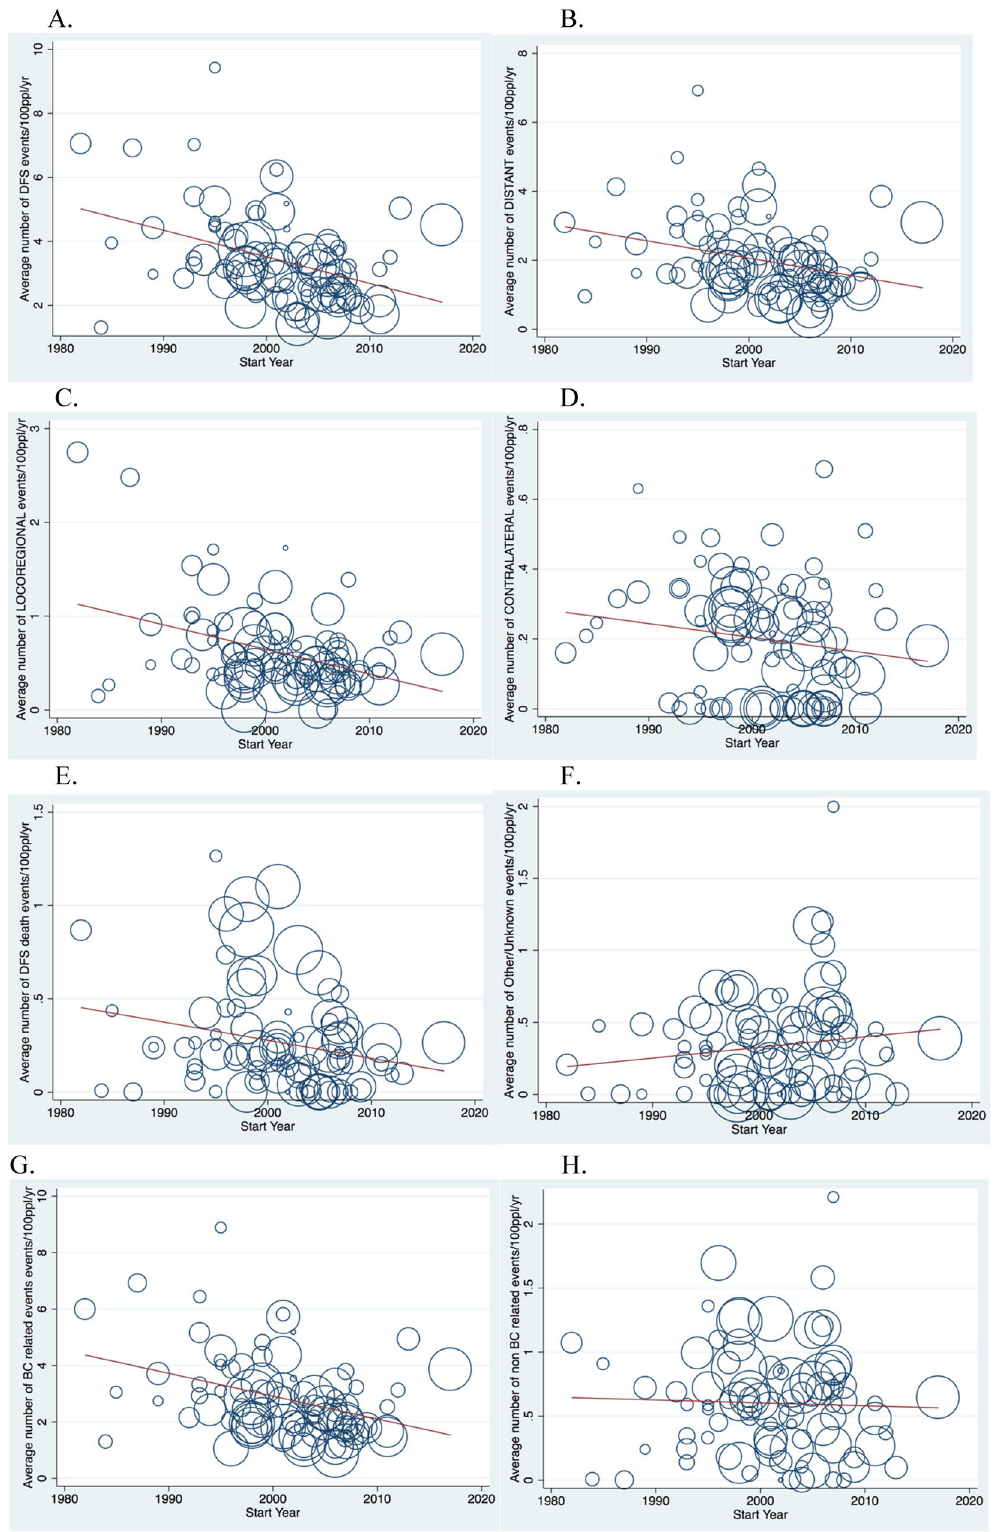
Figure 1. ( A – H ) Average number of DFS events, by type of event, per 100 ppl randomized per year of median follow-up (n =